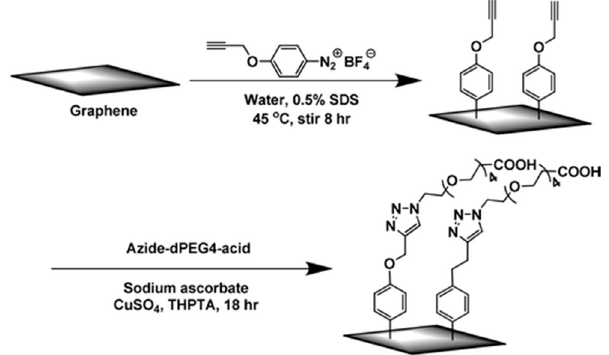
Scheme 6. Diazonium reaction on graphene and subsequent functionalization using click chemistry.